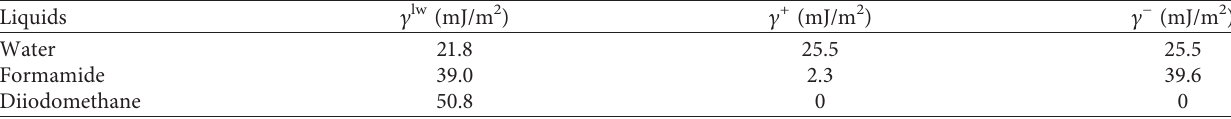
Table 1: Surface energy of contact angle liquids according to van Oss [21].